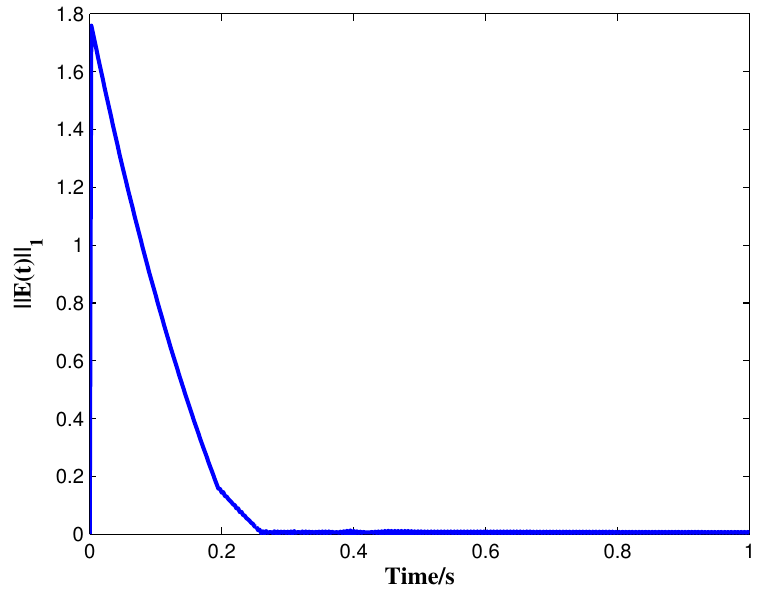
Figure 9. Synchronization errors || E ( t ) || 1 between systems (33) and (34) under ETC condition (39) with η =